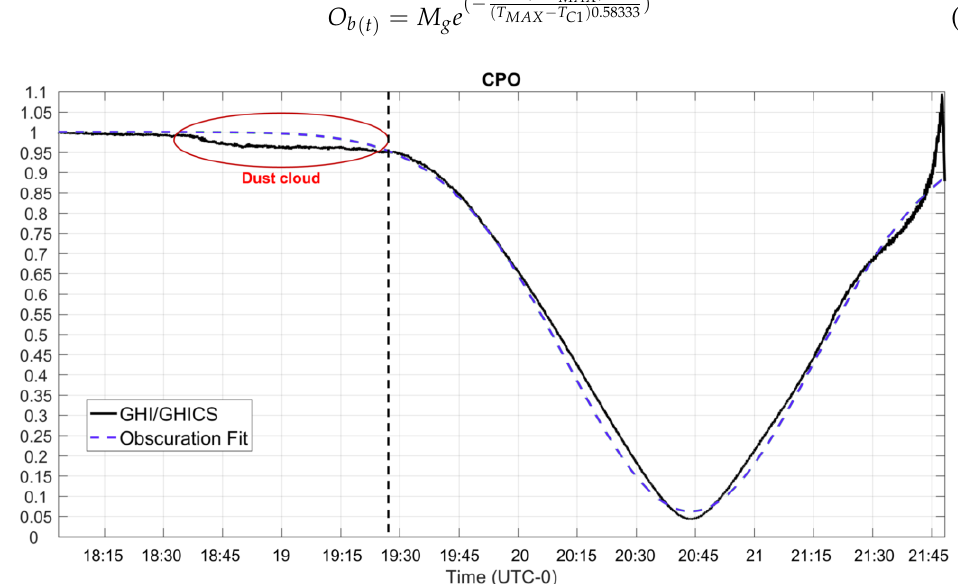
Figure 6. Comparison between modelled and observed effect of the eclipse, using the CPO station as an example . Apparent attenuation before eclipse was caused by a dust cloud. Vertical dashed line marks beginning of the eclipse according to astronomical algorithm.